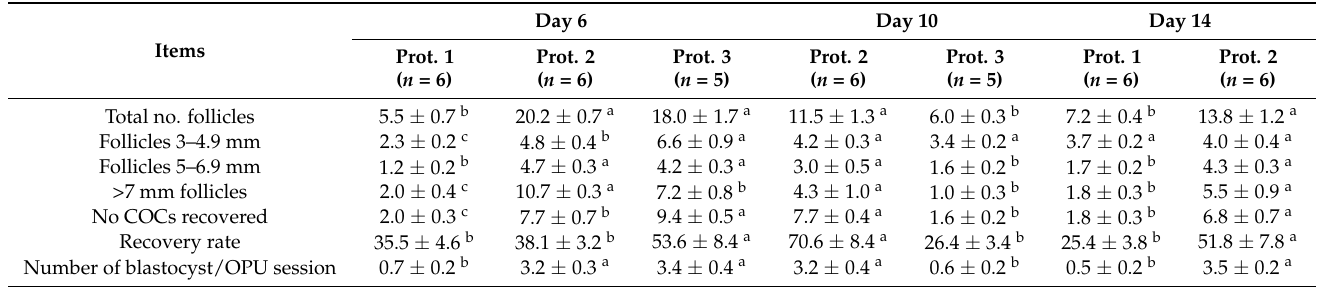
Table 1. Effect of OPU protocol on follicular development, recovery of COCs, and number of blas- tocysts/OPU session in Holstein cows (Mean ± SEM).